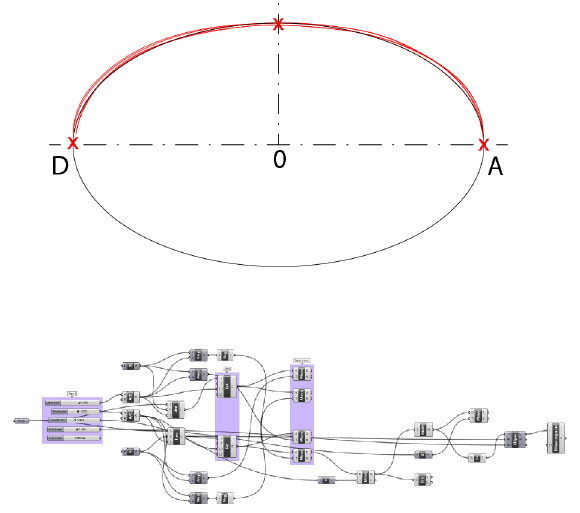
Figure 11 . Visual scripting best fit arches: elliptic curve (Processing: F. Natta).